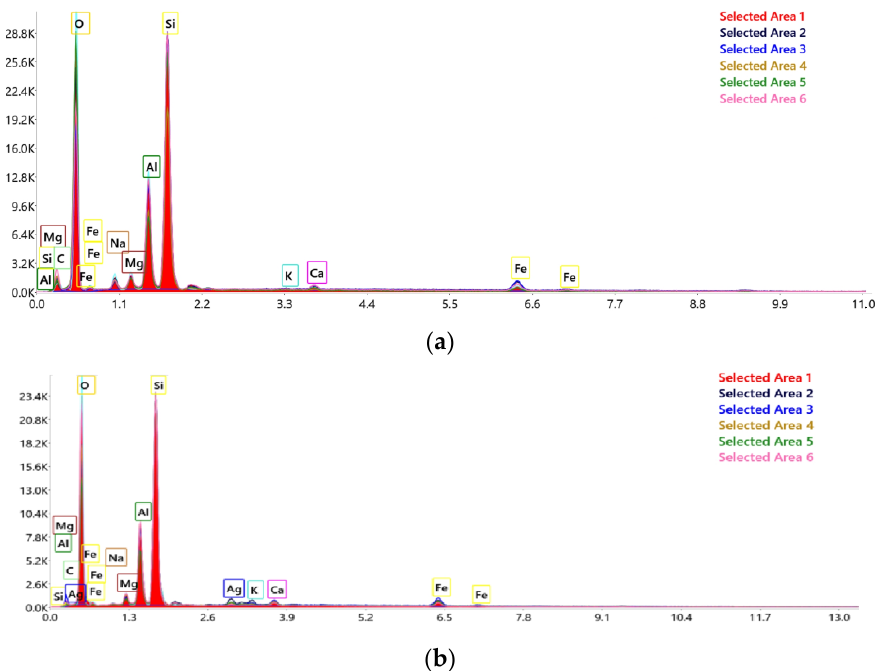
Figure 2. EDAX analysis for six distinct points for BN ( a ) and for BN-Ag 0 ( b ) samples.